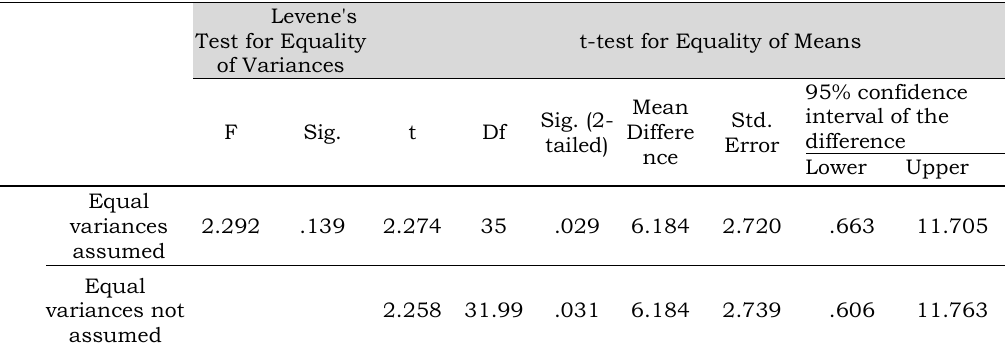
Table 2. The Independent sample t-test of the posttests Levene's Test for Equality of Variances F Sig. t Df